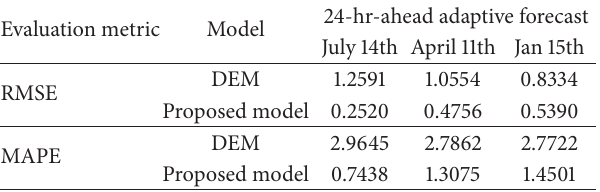
Table 1: Forecasting accuracy metrics for 24-hour-ahead forecast of a typical day in each